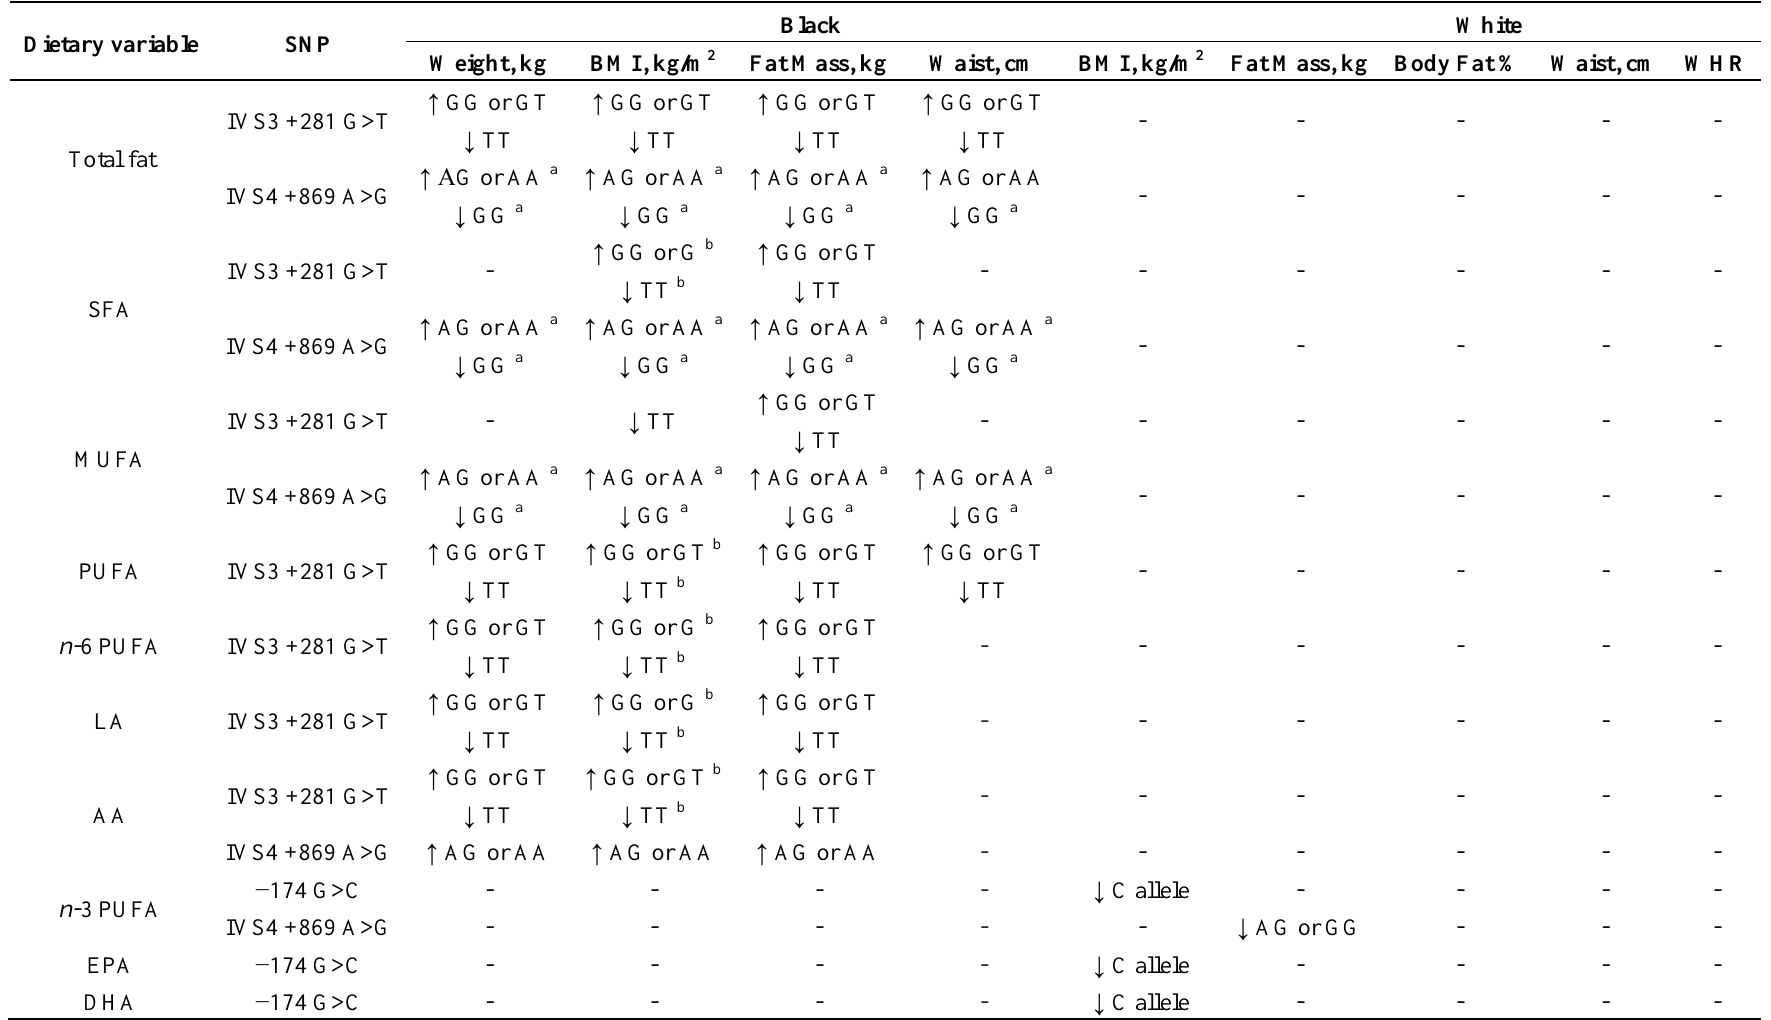
Table 4. Summary of interleukin 6 ( IL-6 ) diet-gene interactions on body